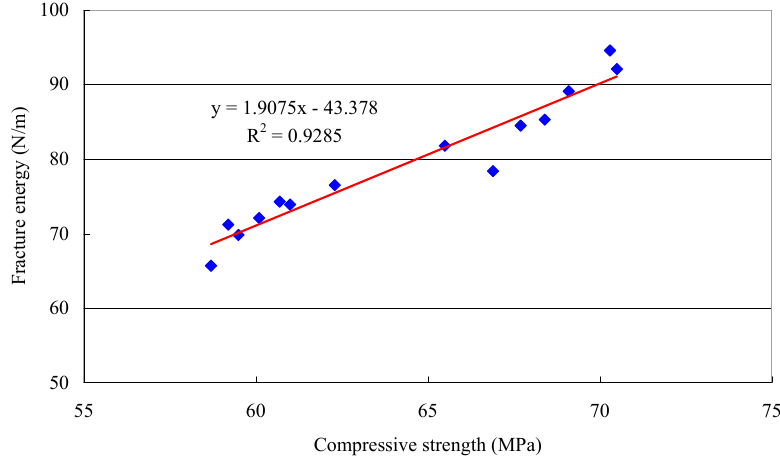
Figure 6. Fracture energy versus compressive strength for slag concretes.